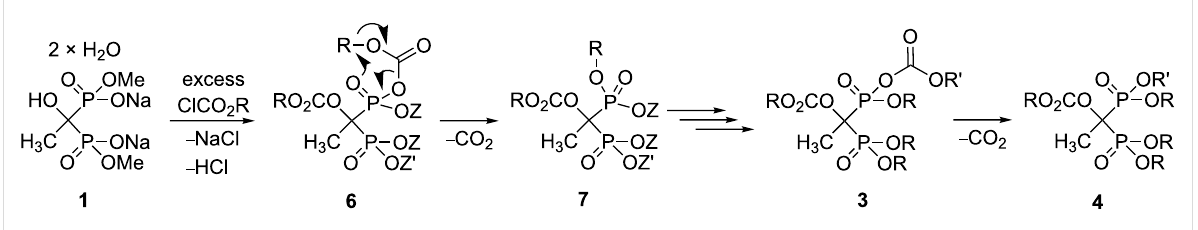
Scheme 2: Possible reaction mechanism for conversion of 1 to 3 and 4 via key